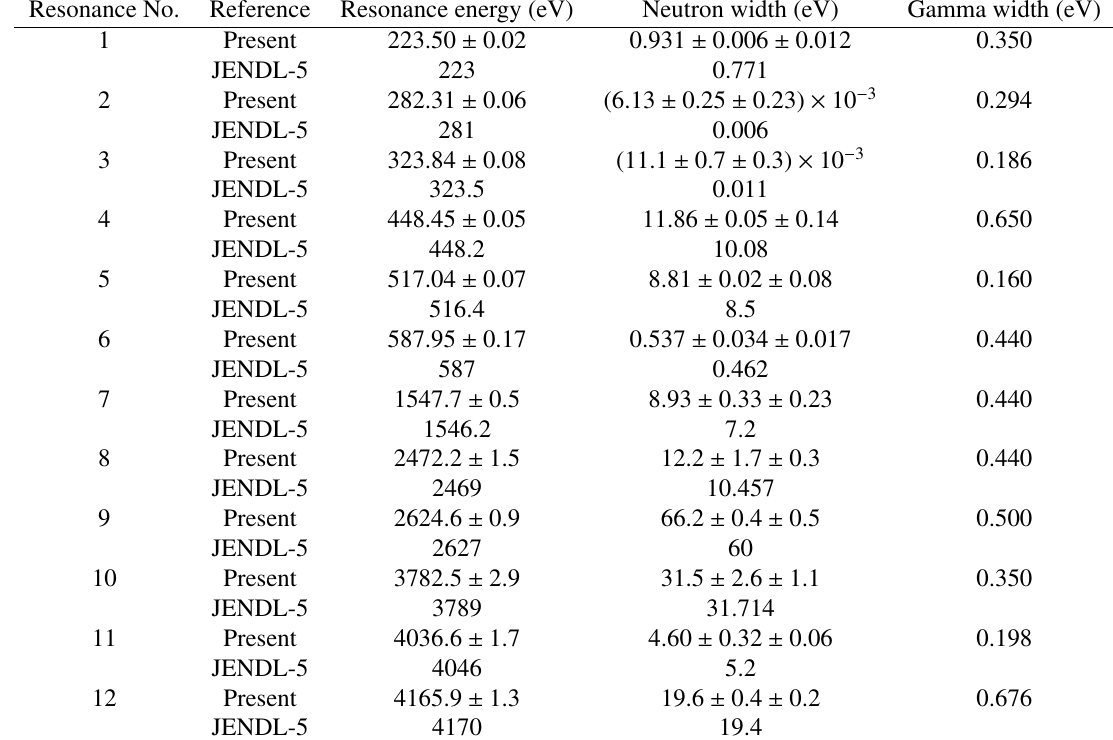
Table 2. Obtained resonance parameters. The gamma width was adopted from JENDL-5 [7]. In the neutron width, the first uncertainty represents the fitting uncertainty, and the second uncertainty represents the systematic uncertainty evaluated by Eq. (2). The uncertainty of the resonance energy was deduced from uncertainties of fitting, flight length and initial time delay. Resonance No.